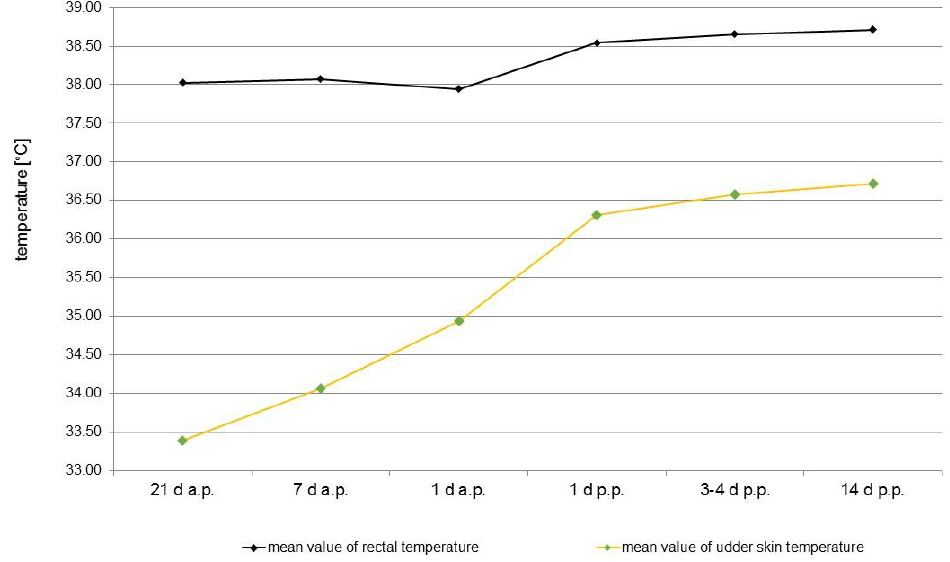
Figure 3. Comparison between the total surface temperature of the udder determined from the mammary glands of all clinical healthy sows (n = 35) and the rectal temperature before and during lactation at different time points (21 d a.p., 7 d a.p., 1 d a.p., 1d p.p., 3–4 d p.p., 14 d p.p.). Mean values of the rectal and surface temperature of the mammary skin are shown.